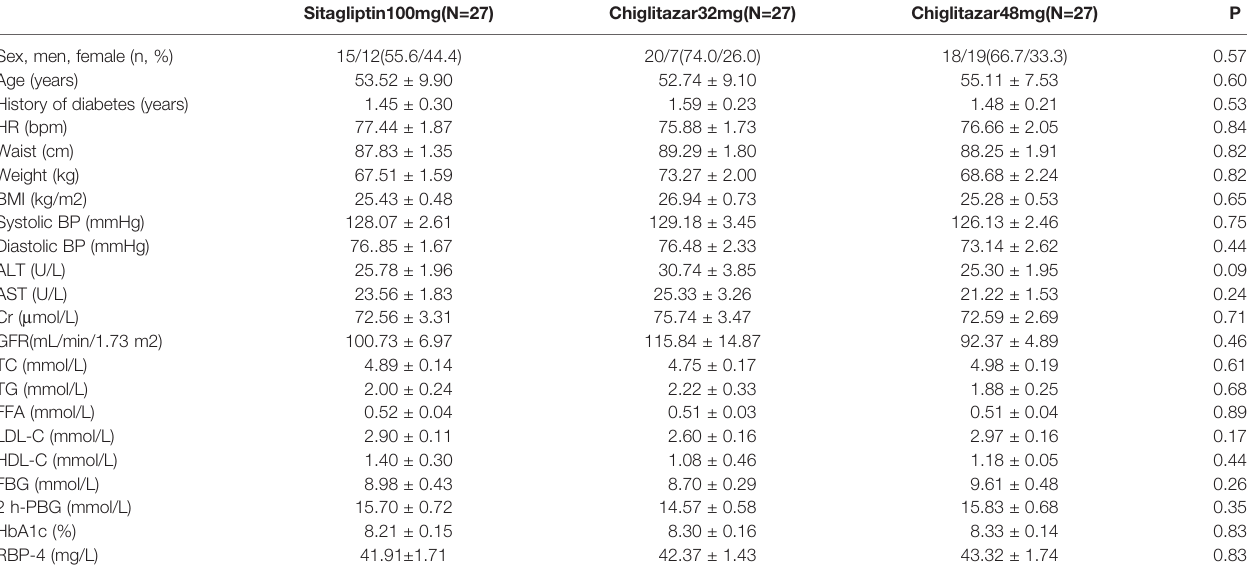
TABLE 1 | Baseline characteristics of study